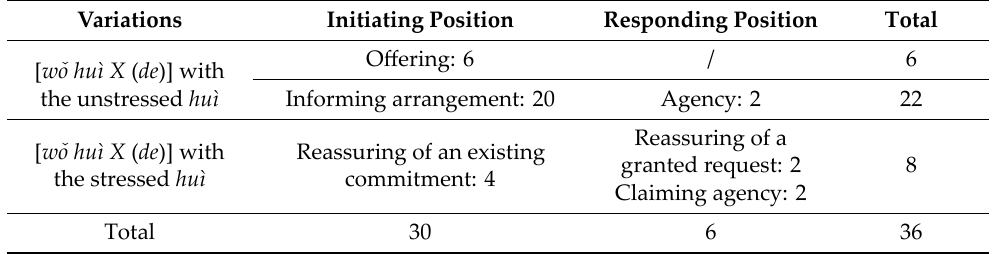
Table 2. Distribution of stressed and unstressed huì in different sequential